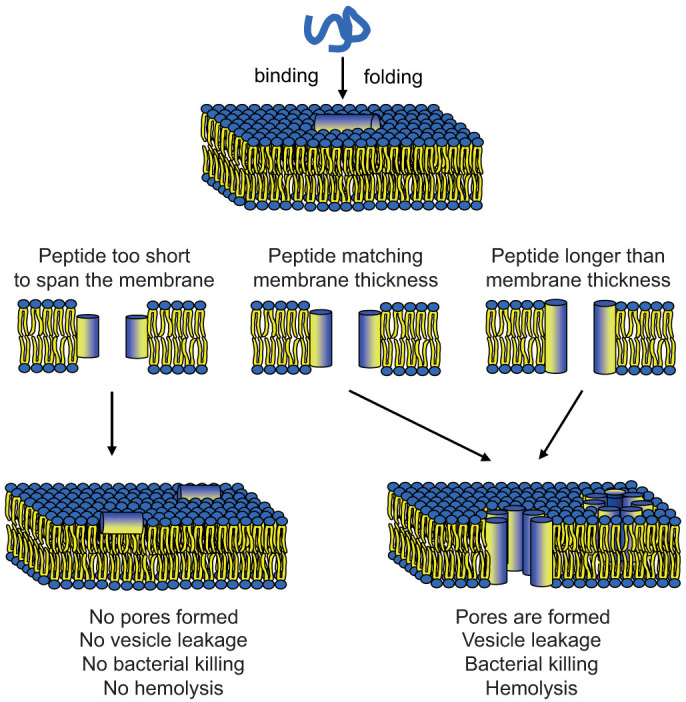
Schematic illustration of the pore formation mechanism proposed to occur for KIA peptides.The peptides are unstructured in solution but form amphipathic α-helices when bound to the membrane, according to CD spectroscopy. If the peptide is too short to span the hydrophobic lipid bilayer core, no pores are formed and the helix remains flat on the membrane surface. If the peptide length matches the bilayer thickness, a transmembrane pore can form with peptides in an inserted, upright orientation. (Pores are depicted as barrel-staves for simplicity of drawing, though they may well be of the toroidal wormhole type with lipid head groups lining the pore).